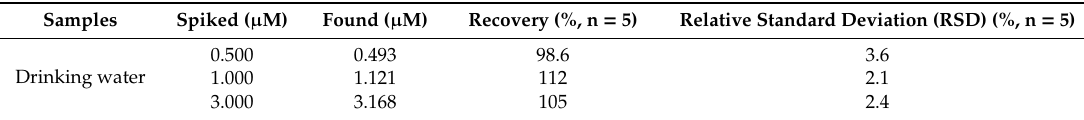
Table 2. Analytical results of drinking water samples.